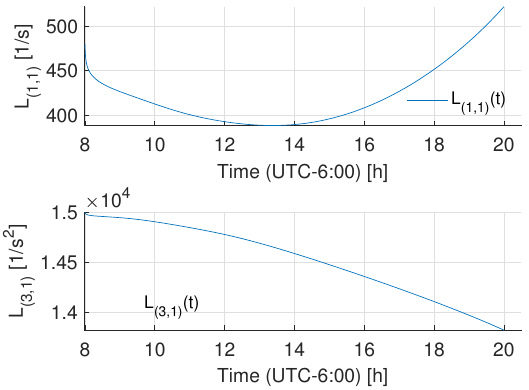
Figure 16. Observer gain behavior for the azimuthal axis injection.